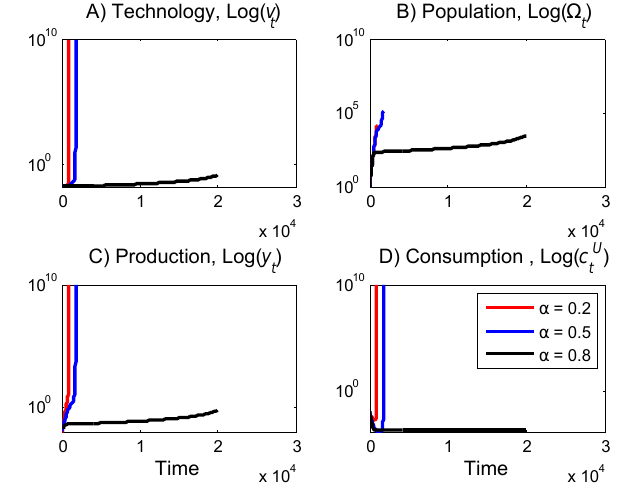
Figure 11. Case of a vulnerable society with marginally productive skilled labor. Assumptions: η = 0.99 to represent a highly vulnera- ble society, low effectiveness of investment on technological change − α − β = 0 . 35 ( γ = 1 E − 3), 1 to represent a skilled labor force that β 0 . 3 is marginally productive over unskilled labor and constant availabil- ity of water resources (i.e., k = 0).